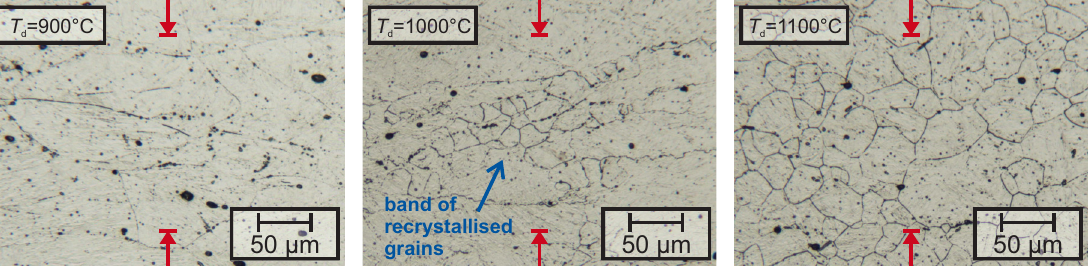
Figure 2. The micrographs show exemplary the microstructure for the investigated samples revealed by nital etching. No significant differences were found in the microstructure if the different alloys were compared with another nor when then different deformation temperatures were compared.